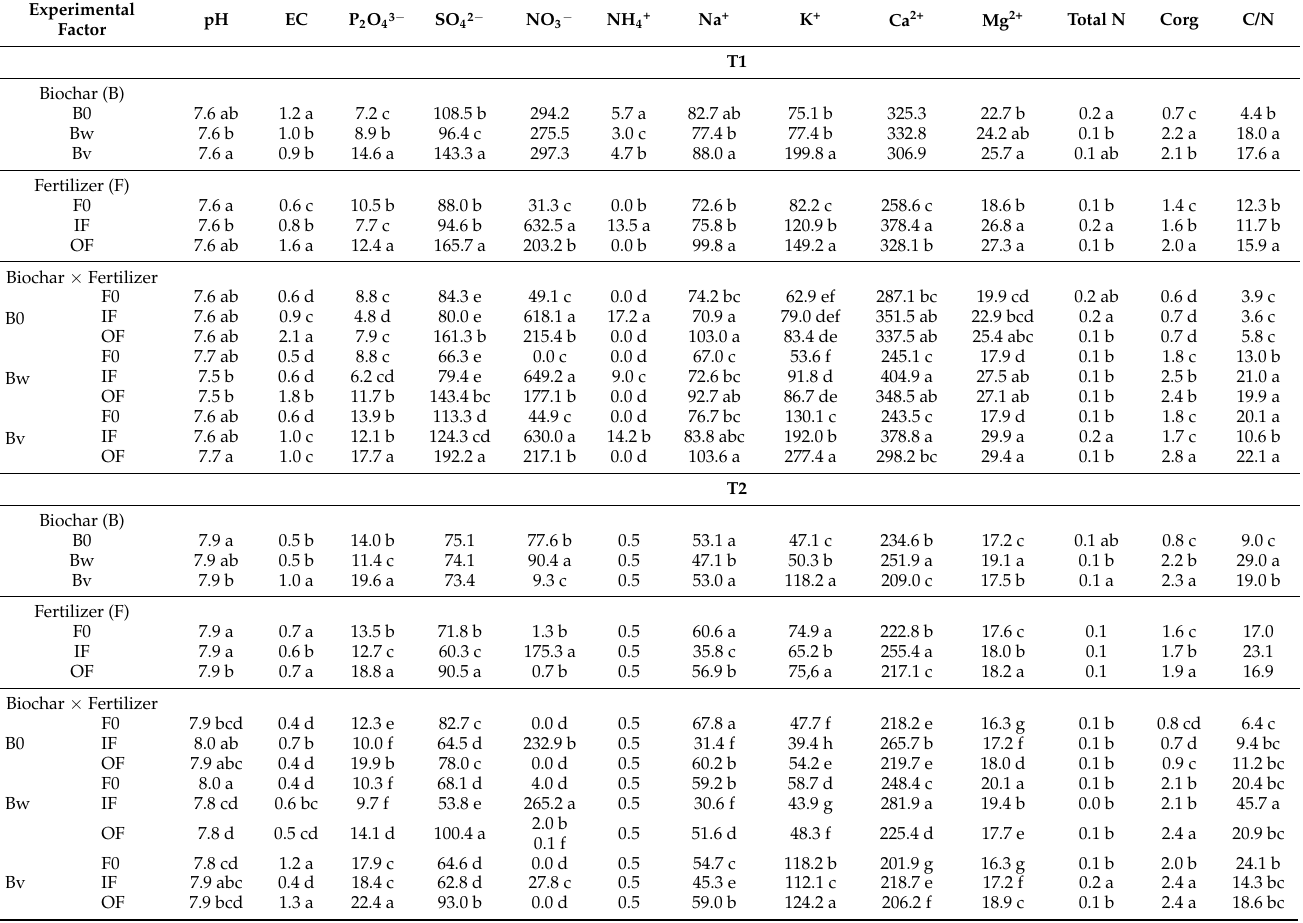
Table 4. Soil pH and electrical conductivity (EC, dSm − 1 ), extractable anion (P 2 O 43 − , SO 42 − , NO 3 − , mg kg − 1 ), cation (NH 4+ , Na + , K + , Ca 2+ , Mg 2+, mg kg − 1 ), total nitrogen (total N, % dw),